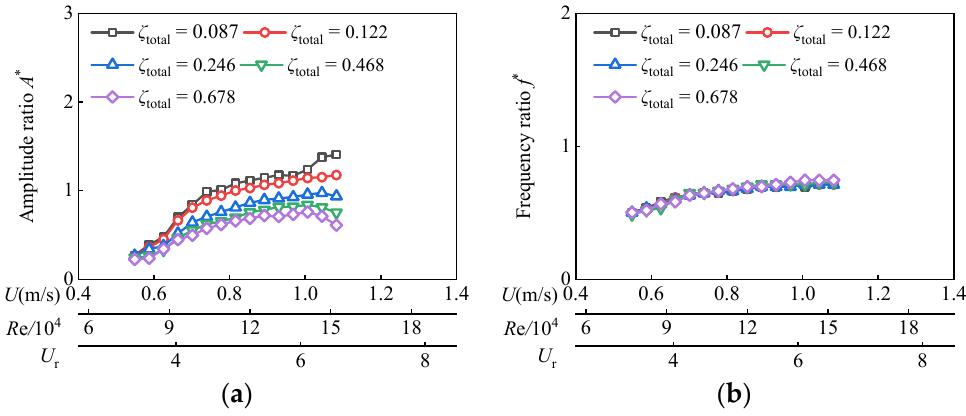
Figure 10. FIM of Cir-T-Att with D = 0.16 m, Re = 7.71 × 10 4 ~1.84 × 10 5 . ( a ) Amplitude ratio. ( b ) Frequency ratio.